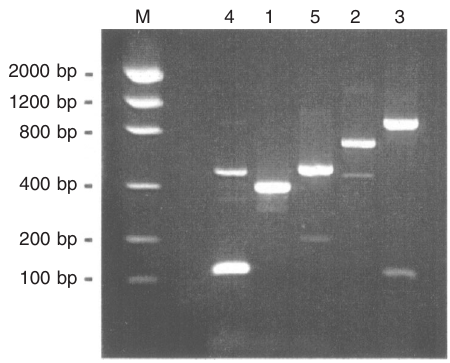
Figure 2. Agarose gel (2%) elec- trophoresis of PCR products. Each PCR assay was performed with a different plasmid and six oligonucleotide primers (one sense and five antisense). M: molecular weight markers. Num- bers 1-5 at the top represent the phylogenetic groups of the Torque teno virus sequences carried by the corresponding template recombinant